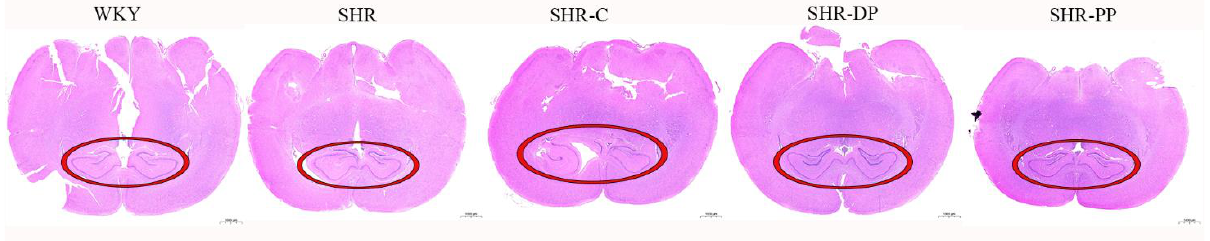
Figure 5. The representative micrographs of rat brain with the HE staining (1×); hippocampus is represented by circle.